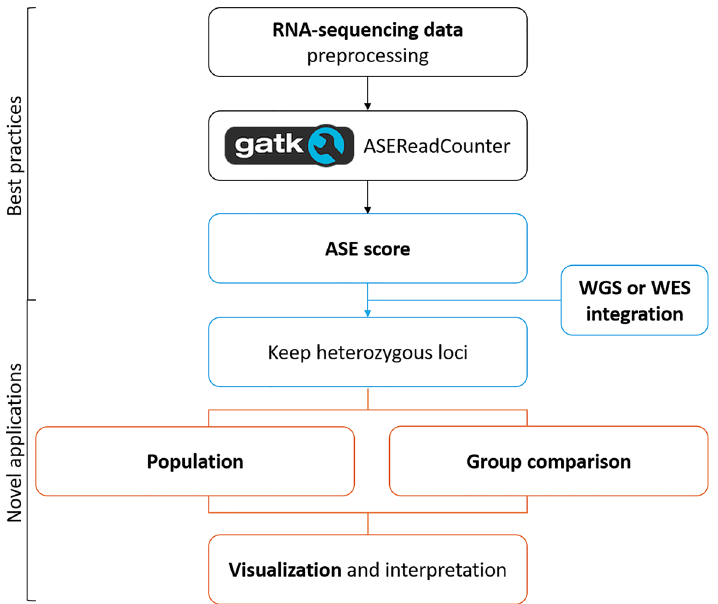
Figure 1. Overview of the pipeline. This analysis plan allows the inclusion of genotyping data to increase data retrieval and statistical power. The data can be evaluated on three distinct levels, with suiting visualizations for all of them in order to create interpretable results. The integration of WGS or WES data, the group comparisons, and the visualizations are novel additions to established ASE analysis